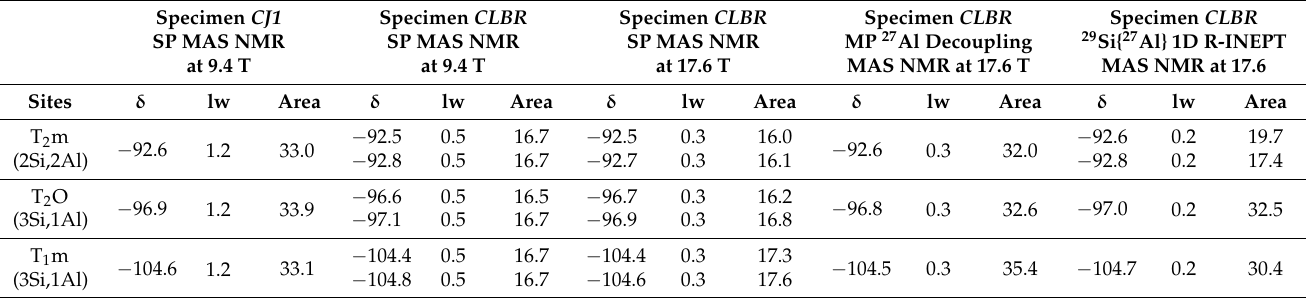
Figure 23. The 29 Si MAS NMR spectra of K- feldspar in the “X - ray microcline” variant at 9.4 T. ( a ) Specimen 9544, spectral simulations require three components for Si atoms at T 1 m, T 2 O and T 2 M sites, rotor 4 mm, pulse 4 μs, ν r = 10 kHz, recycling delay of 1800 s. ( b ) Specimen 11924, spectral simulations require three components (three doublets) for Si atoms at T 1 m, T 2 O and T 2 M sites, rotor 4 mm, pulse 0.5 μs, ν r = 14 kHz, recycling delay of 45 s. See text and Table 11 for explanations. Table 12. The NMR parameters of the simulation of the 29 Si spectra in specimens CJ1 and CLBR, “X-ray low albite” (LA) variant, at 9.4 T and 17.6 T (see Figure